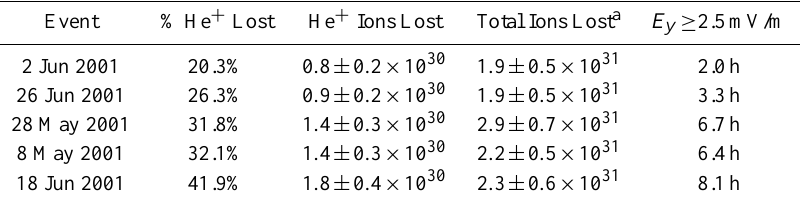
Table 1. Summary of the loss calculations for the five disturbance periods. a The total ions lost calculation uses the α ratio from (Craven et al.,